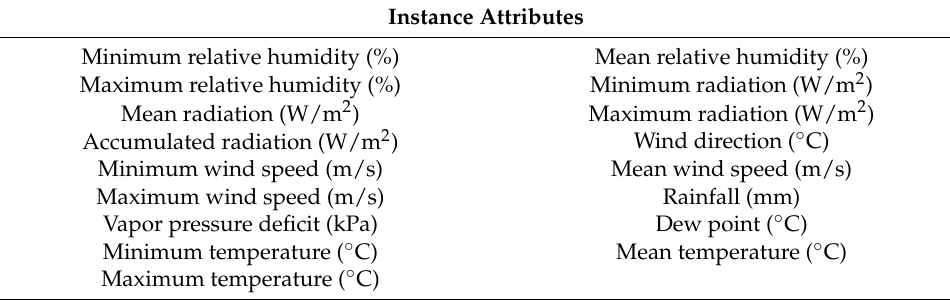
Table 1. Instance attributes after grouping the data of each hour.